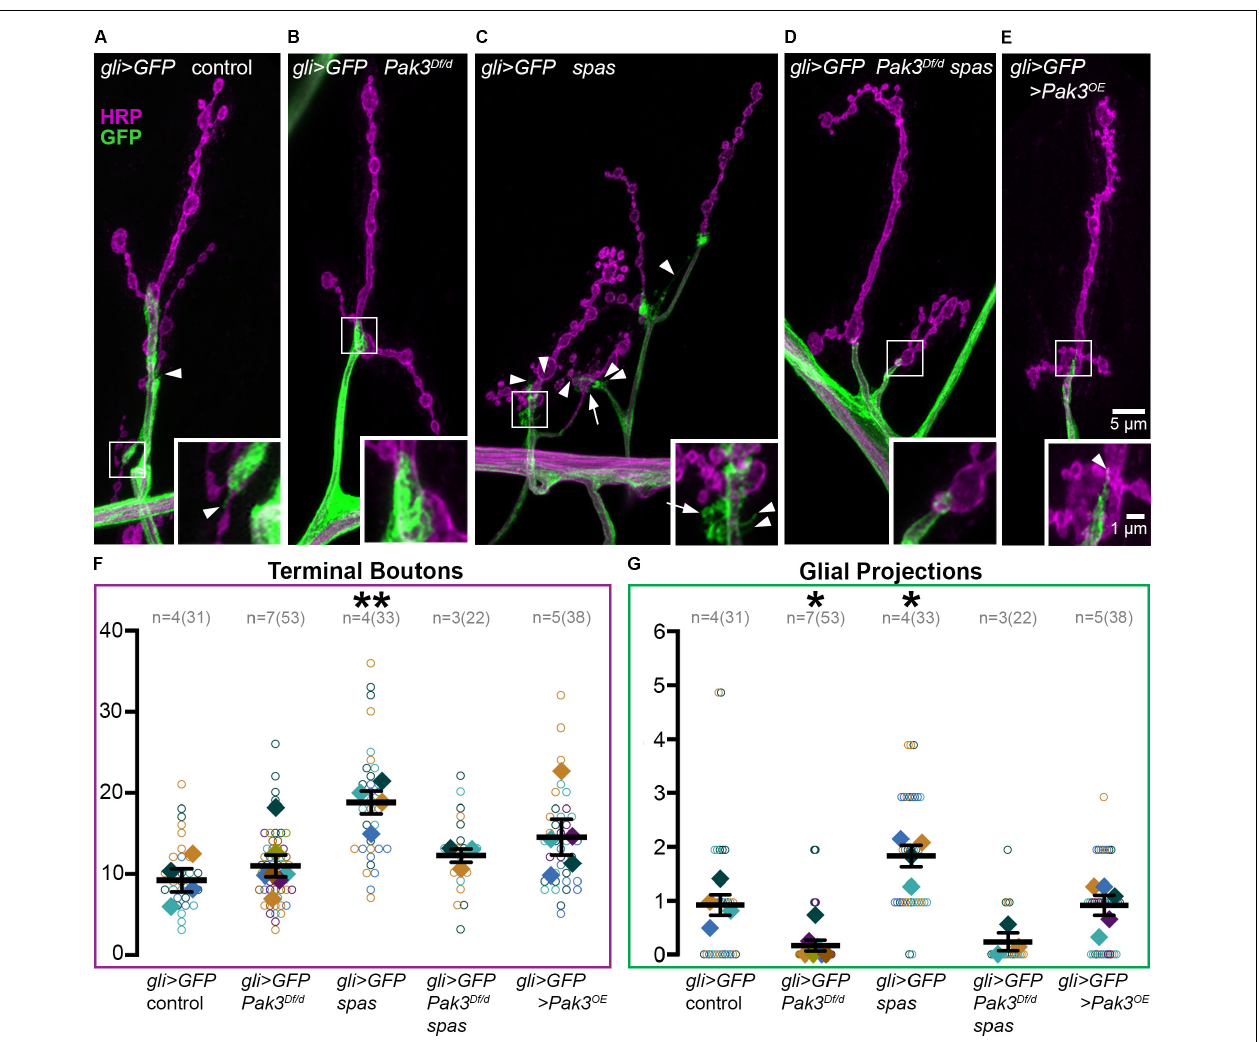
FIGURE 3 | Subperineurial glia projections depend on Pak3 and are doubled in spastin mutants. (A–E) Anti-HRP shows neuronal morphology in magenta, anti-GFP shows glial morphology in green. (A) gli-GAL4, UAS-mCD8::GFP ( gli > GFP ) controls have linearly arrayed synaptic boutons and average one glial projection (arrowhead) per muscle 4. (B) Pak3 loss of function mutants, gli > GFP ; Pak3 Df / Pak3 d 02472 (abbreviated “ Pak3 Df / d ”) have similarly arrayed bouton arbors but very few glial projections. (C) spastin 5 . 75 loss of function, gli > GFP ; spas , causes extra glial projections in addition to extra terminal boutons. These projections include thin glial filopodia (arrowheads) and round glial projections (arrows). (D) Consistent with these extra glial projections requiring Pak3 function, gli > GFP ; Pak3 Df , spas / Pak3 d 02472 , spas double mutants display few glial projections, and have wild type bouton arbors. (E) Overexpression of Pak3 in subperineurial glia does not affect glial projections or terminal bouton numbers compared to controls, although small, clustered terminal boutons are observed. (F,G) Graphs of individual (open circles) and averaged (solid diamonds) values per larva for terminal boutons (F) and glial projections (G) are shown for each of the genotypes in (A–E) . Significant differences relative to gli > GFP controls are calculated by one-way ANOVA followed by Sidak’s multiple comparisons test. P -values are denoted as * for 0.01 < p ≤ 0.05, and ** for 0.001 < p ≤